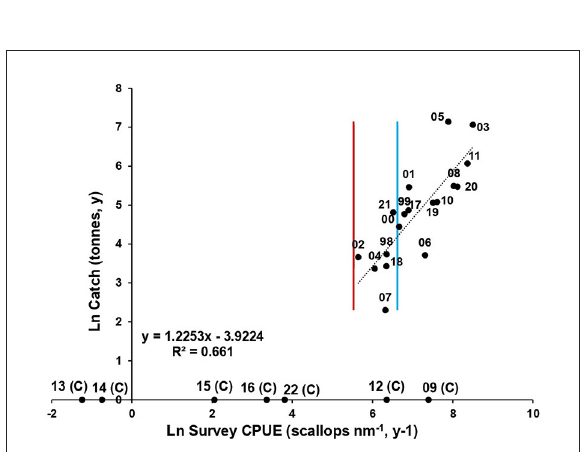
FIGURE7 Abrolhos Is. catch prediction model based on total abundance of 0 + and 1 + scallops nm − 1 between 1997 to 2021 (black dots) (closed years excluded). Limit (red vertical line) and threshold (blue vertical line) reference levels indicated.